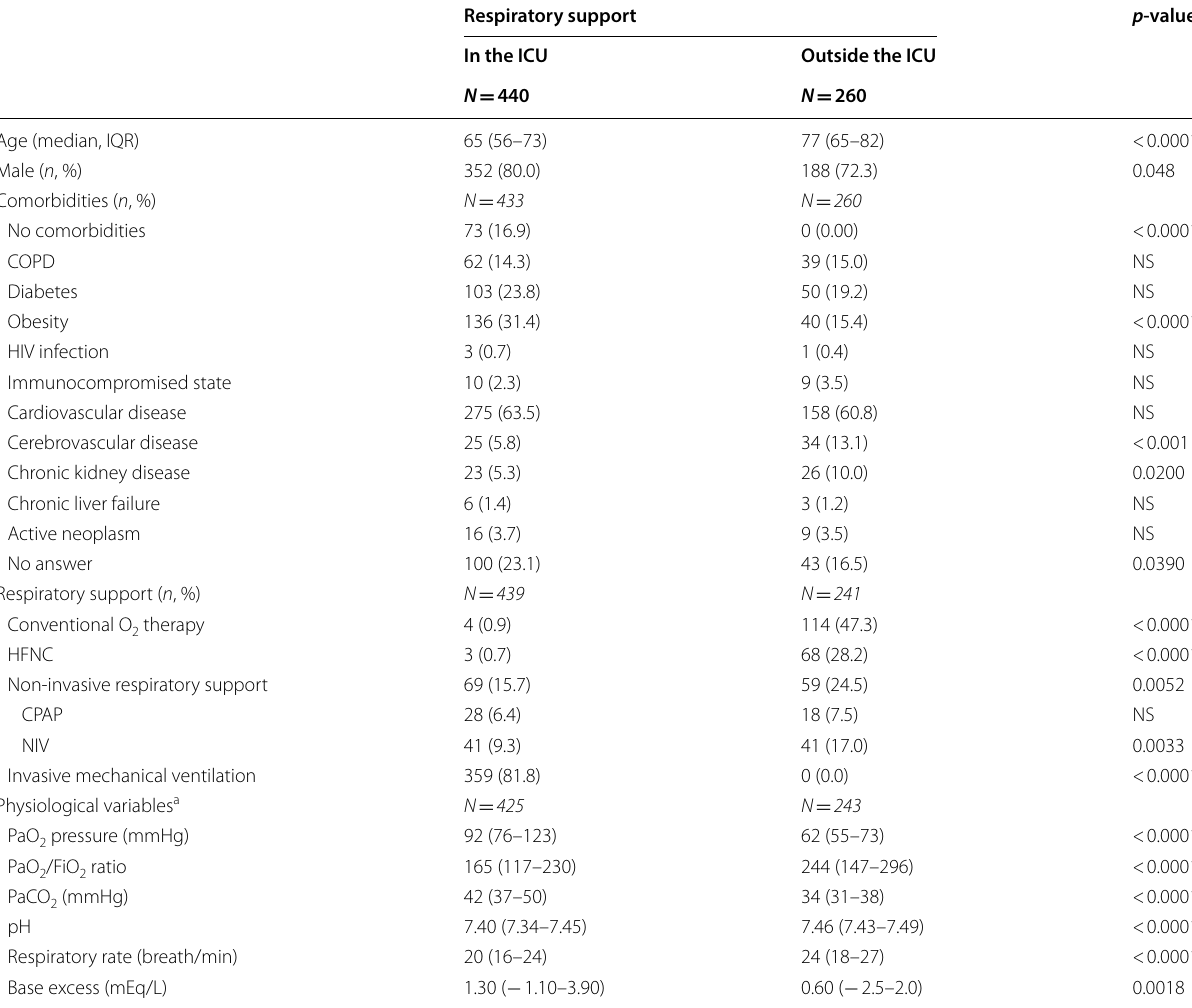
Table 1 Characteristics of patients receiving respiratory support in the ICU and outside the ICU under intensivist